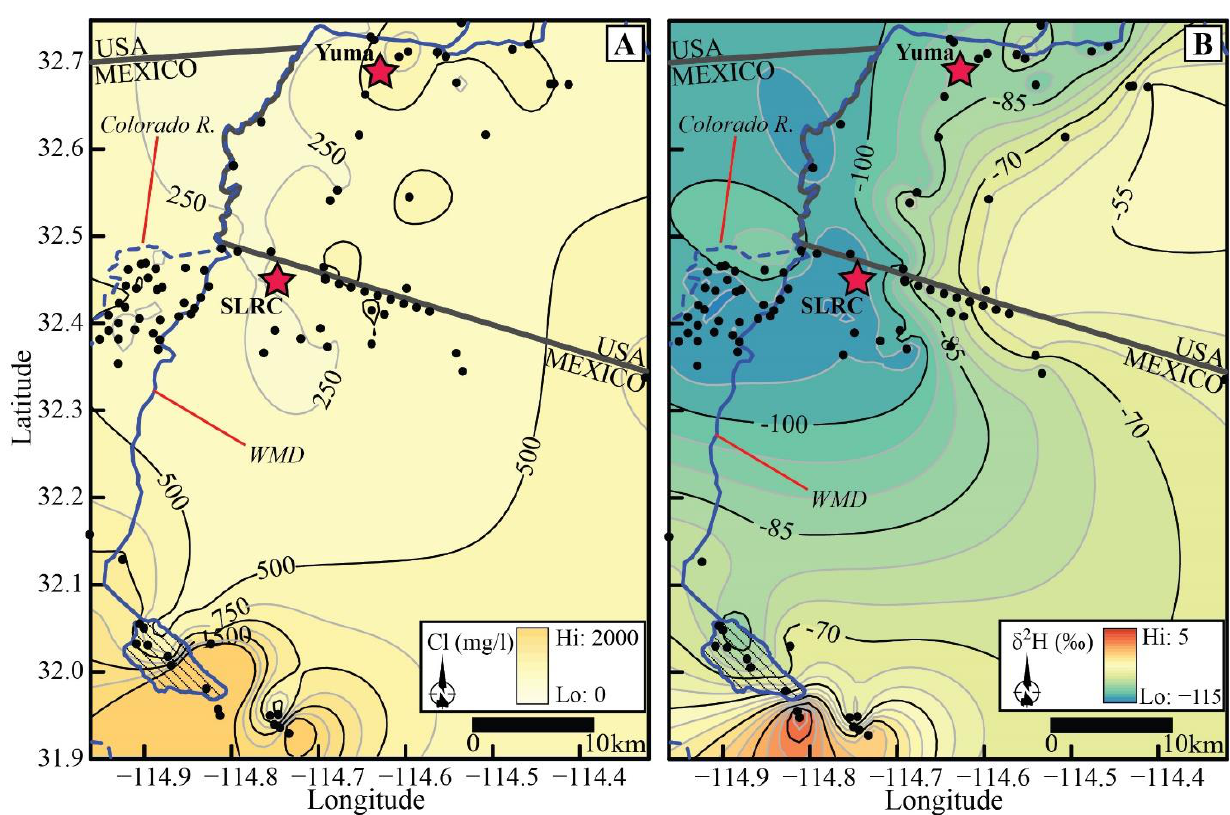
Figure 11. ( A ). Contour map showing spatial patterns for Cl − . ( B ) Contour map showing spatial patterns for δ 2 H. Black-filled circles represent control points. SLRC: San Luis Rio Colorado, Mexico. WMD: Wellton-Mohawk Drain.